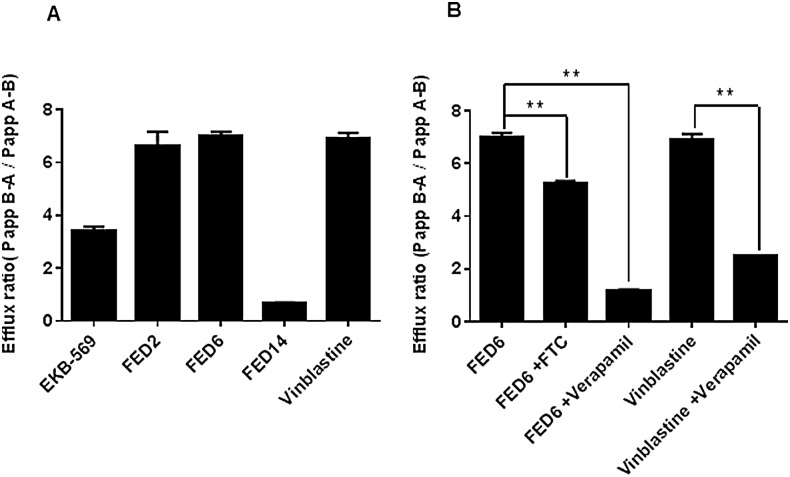
Efflux ratios of cyanoquinoline compounds in caco2 transwell assay.A. Efflux ratios of selected cyanoquinoline compounds. B. Efflux ratios of FED6 and vinblastine with or without pre-treatment with 10 mg/mL of verapamil or 10μM of fumitremorgin C (FTC) for 1 h. All data shows mean ± SE of triplicates, repeated twice. Statistically significant differences between data obtained following an unpaired t-test are indicated on graph; (* = p < 0.05, ** = P < 0.01).